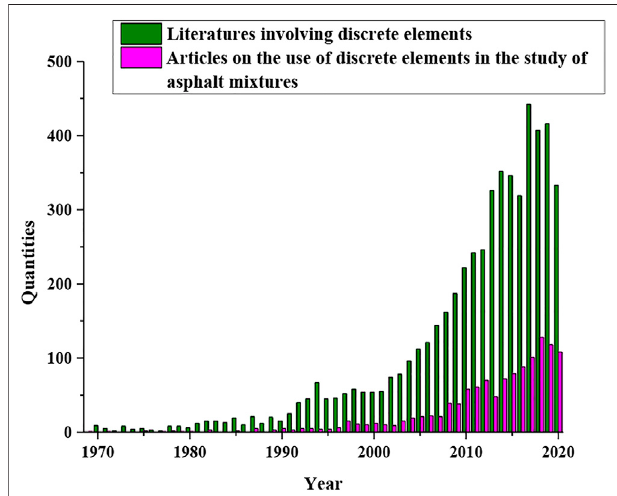
FIGURE 1 | Trends for the discrete element method (DEM) in the literature